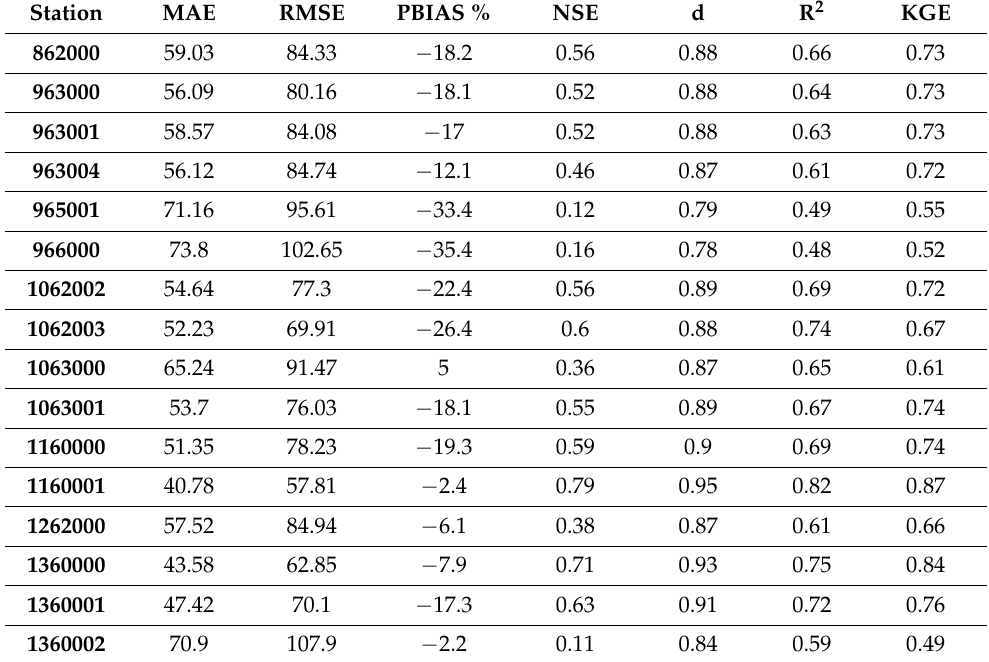
Table 3. Values of the validation metrics of the values estimated by CHIRPS according to the values collected by the rain gauges.